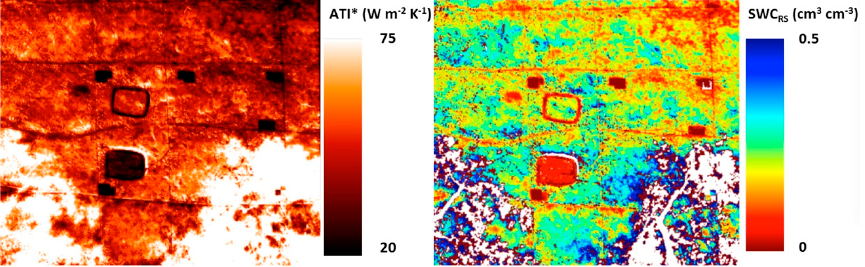
Figure 6. Apparent thermal inertia (ATI)* spatial distribution (left panel) and pseudo color composition of SWC R S (right panel); shadowed pixels are in white highlighted masked.